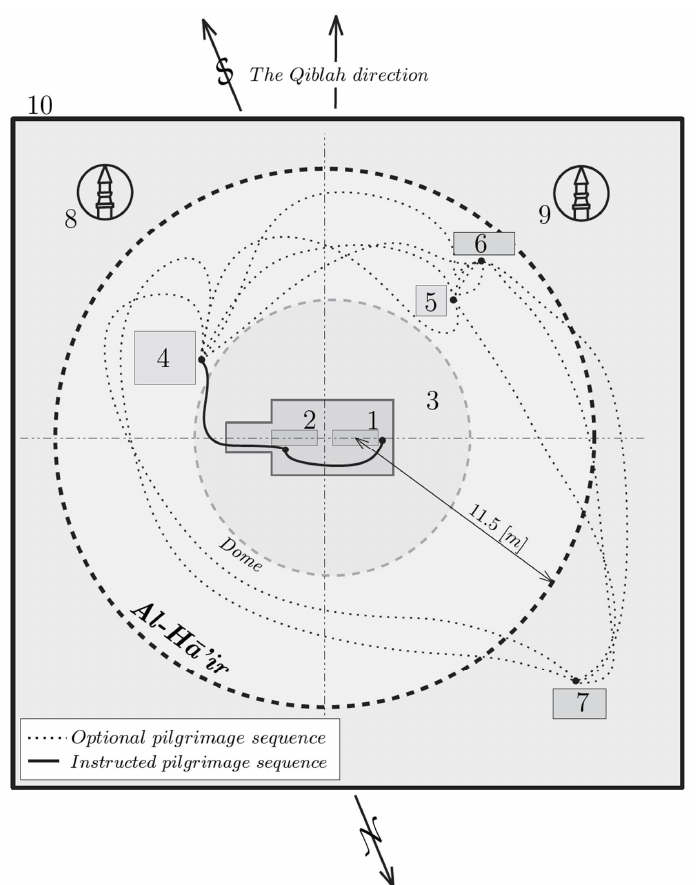
Figure 3. Concentric and other peripheral sacred places and spaces at Imam al-Husayn’s Holy Shrine in Karbala. Source: Original Graphic. Rendered from sketch and conversation with Muhammad-Reza Fakhr-Rohani, 2021.